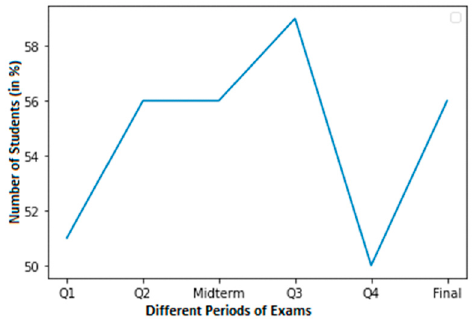
Figure 4. Less cheating dataset of a student with normal grades.